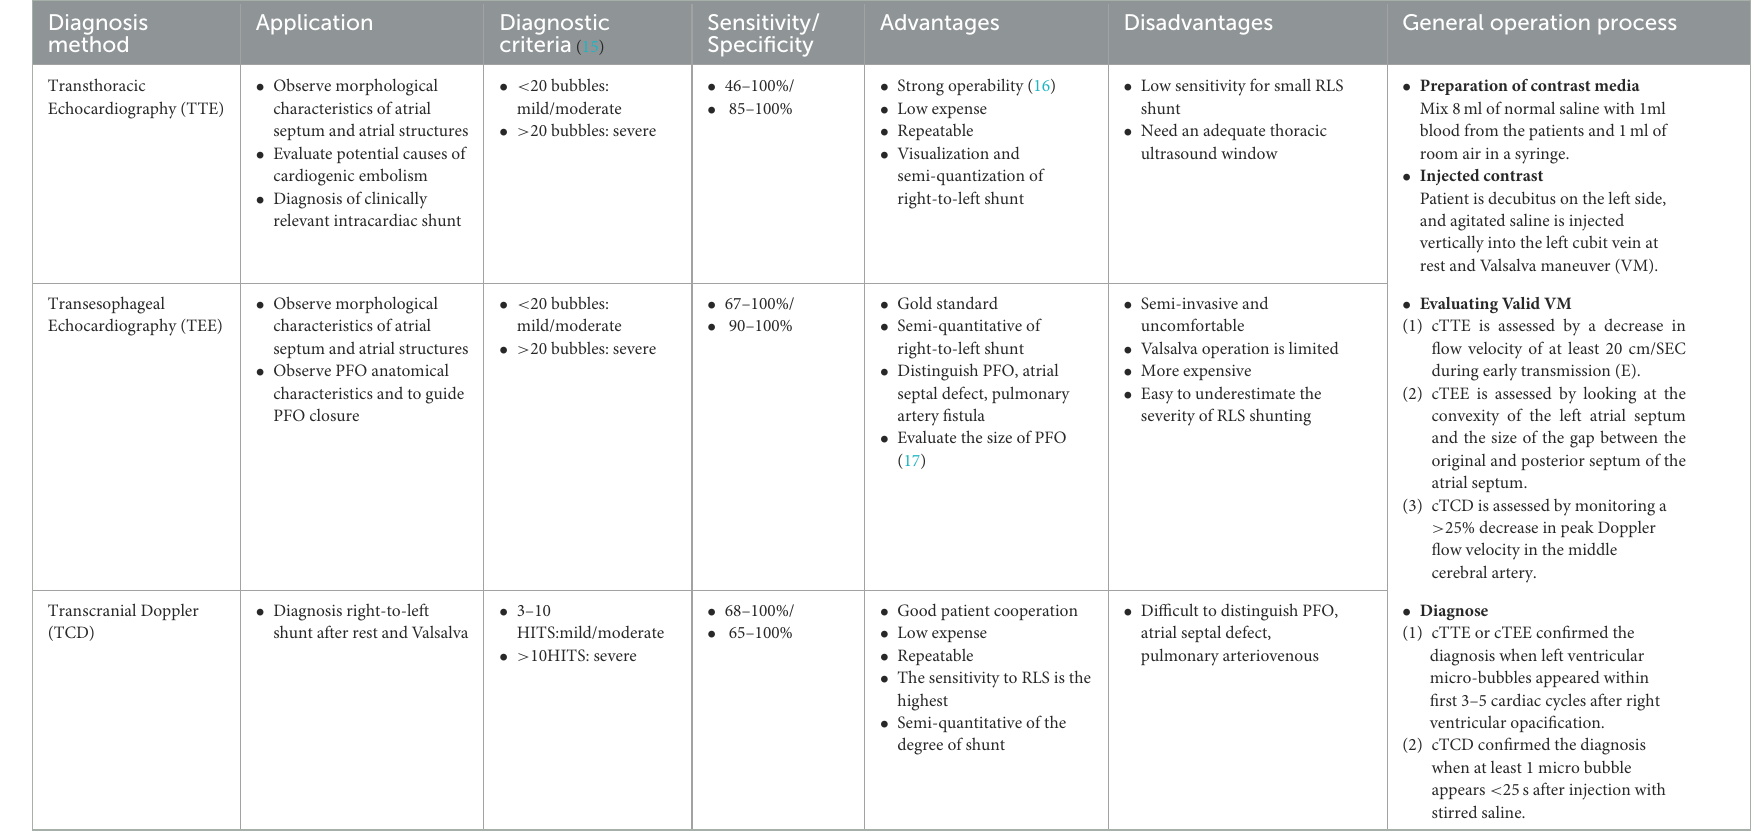
TABLE 1 Comparison of different diagnostic techniques for